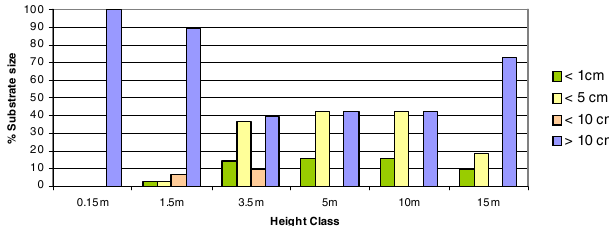
Figure 4. Orientation of the available substrate and percent- age usage by L.t. tardigradus